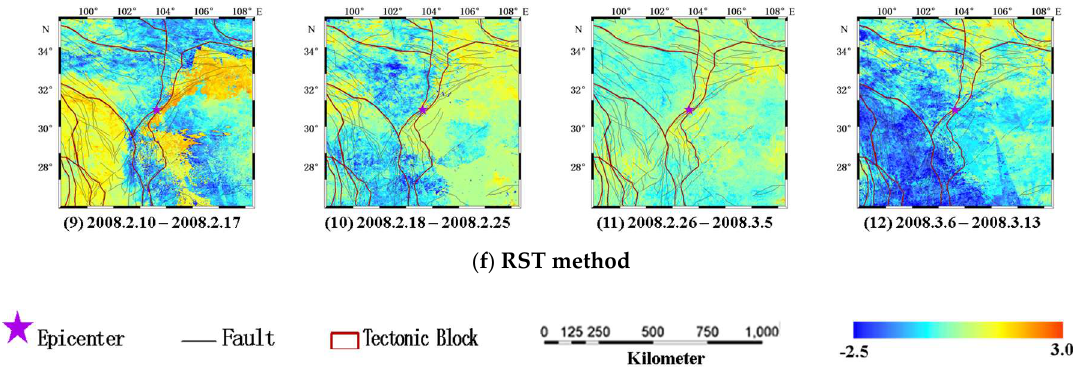
Figure 19. Comparison of spatio-temporal evolution of TIR anomalies extracted by the RST method and TTIA method respectively in the Longmenshan fault region half a year to 2 months before the period Ms 8.0 Wenchuan earthquake event.